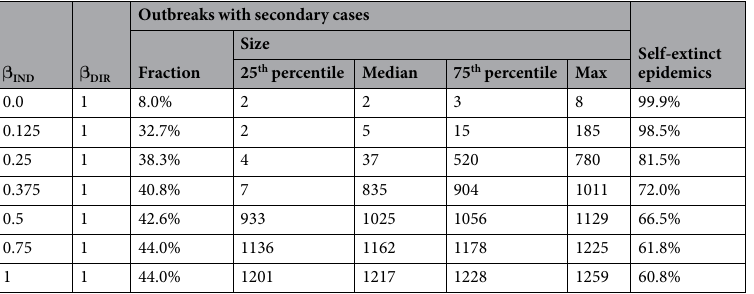
Table 1. β ind sensitivity analysis indicators. Indicators for the indirect contact transmission probability β ind sensitivity analysis based on 5,000 runs for each parameter defined scenario. We showed the percentage of epidemics with secondary cases, and for those epidemics the 25 th , 50 th (median), 75 th quantiles and the maximum, and finally the number of self-extinct